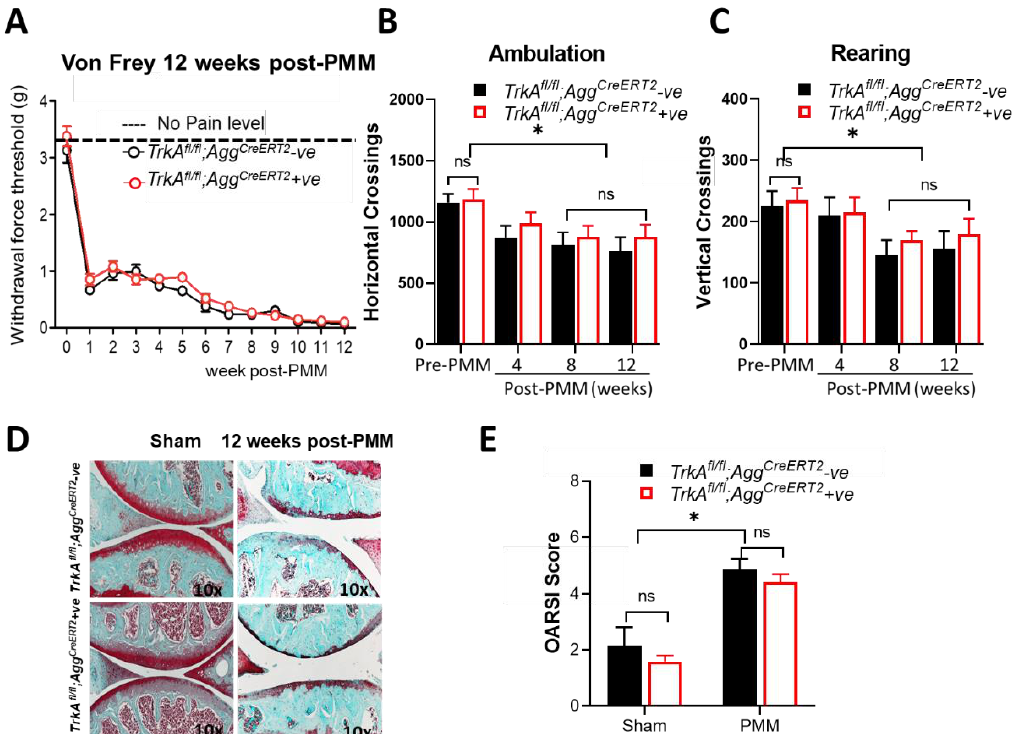
Figure 2. Cartilage-specific deletion of TrkA in mice did not improve either OA-associated hypersensitivity to pain or knee joint pathology with OA progression. OA was induced by PMM in 12-week-old TrkA fl/fl ;Aggrecan CreERT2 -positive ( n = 13) and TrkA fl/fl ;Aggrecan CreERT2 -negative control mice ( n = 6), followed by harvesting knee joints at 12 weeks after PMM. Each knee shown is representative of a group of mice. ( A ) Development of mechanical allodynia (von Frey filament testing) in the ipsilateral hind paw, comparing TrkA fl/fl ;Aggrecan CreERT2 -negative and TrkA fl/fl ;Aggrecan CreERT2 -positive mice following PMM. There were no significant differences. ( B ) Ambulation (horizontal photo beam crossings) and ( C ) spontaneous rearing activity (vertical photo beam crossings) were not different in TrkA -deleted mice compared with the control after PMM, while both activities were reduced between pre- and advanced OA. ( D ) Histological assessment for proteoglycan depletion by Safranin-O fast green staining ( × 10). ( E ) Severity of articular cartilage degradation was graded using the Osteoarthri- tis Research Society International (OARSI) scoring system. Values are mean ± SEM. * p < 0.05, ns: not significant. p = 0.644 (sham), p = 0.376